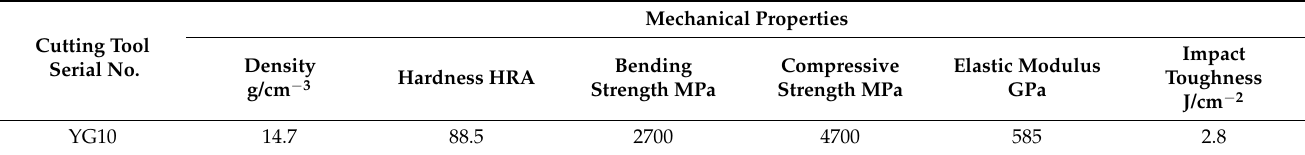
Table 4. Mechanical properties of bit materials.